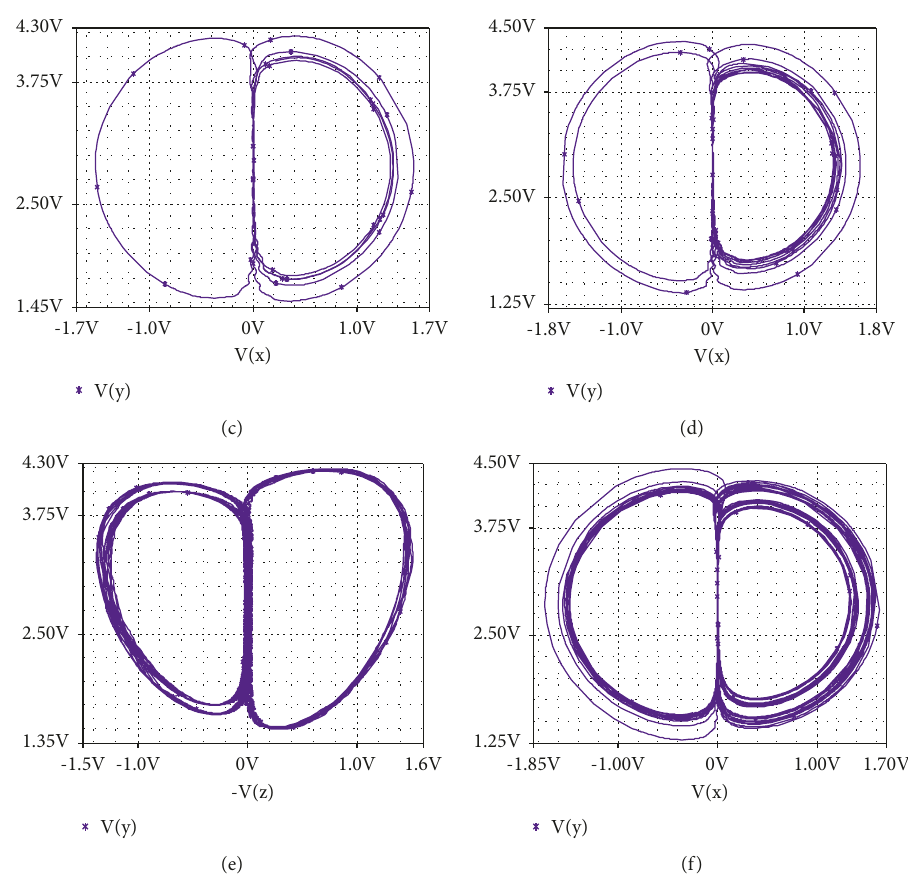
Figure 22: Phase portraits of system (11a–11c) in (Vx, Vy) plane of the circuit in Figure 21 show the behavior of the system obtained in OrCAD-PSpice when the load torque in a square signal. (a) R 40 � 500k Ω , (b) R 40 � 505.254k Ω , (c) R 40 � 380.55k k Ω , (d) R 40 � 800k Ω , (e) R 40 � 850.8k Ω , and (f) R 40 � 950.698k Ω . The initial values of capacitors voltage are ( V X ( 0 ) , V y ( 0 ) , V z ( 0 ))� (0.01V, 0.01V, 0.01V), the value of some resistance is R 21 � R 37 � 3.278k Ω , and other parameters are unchanged.